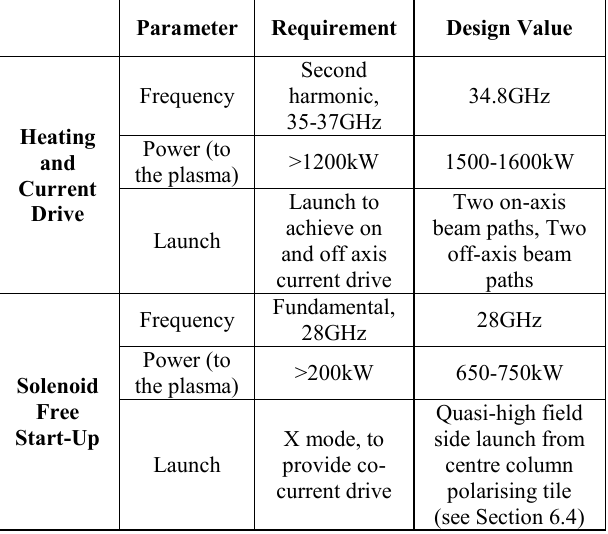
Table 1. System requirements and design values